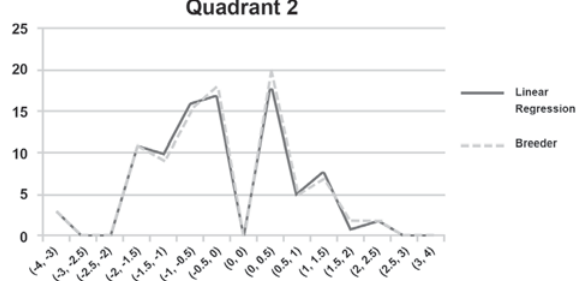
Figure 4- The comparison of prediction error in quadrant 2